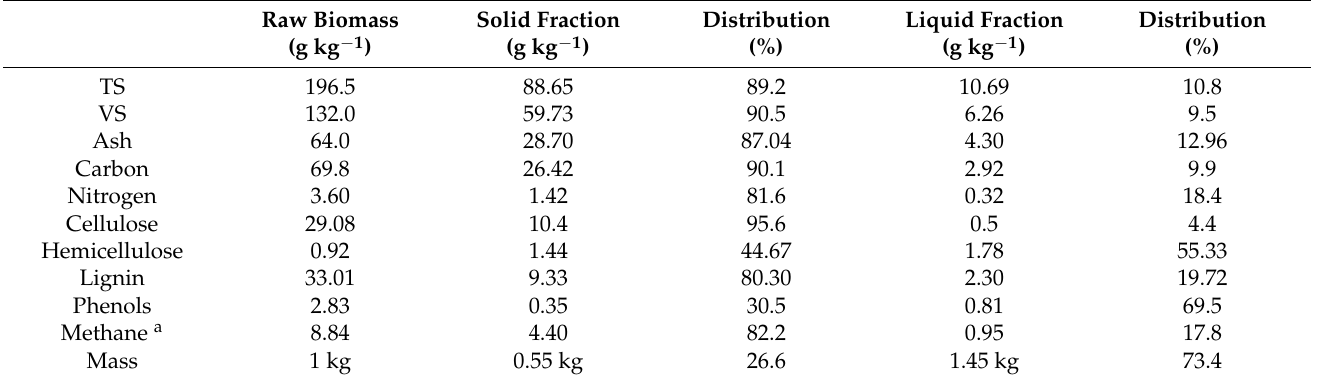
Table 6. Distribution of biomass components after the solid–liquid separation process.